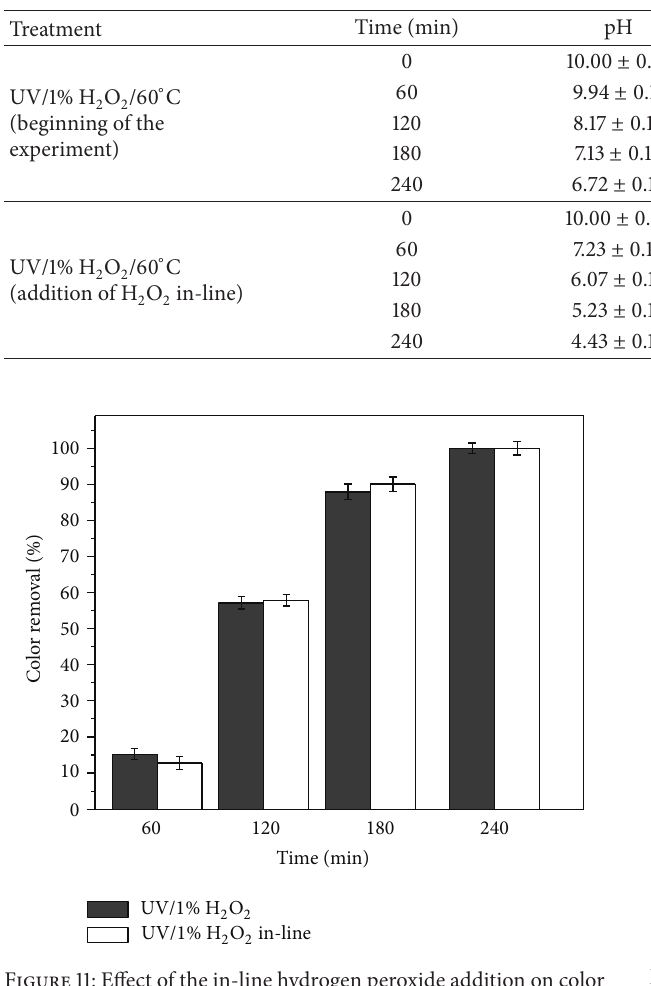
Table 5: Effect of the irradiation time and in-line addition in some physical-chemical parameters. Experimental conditions: initial pH of 10 and 60 ∘ C.